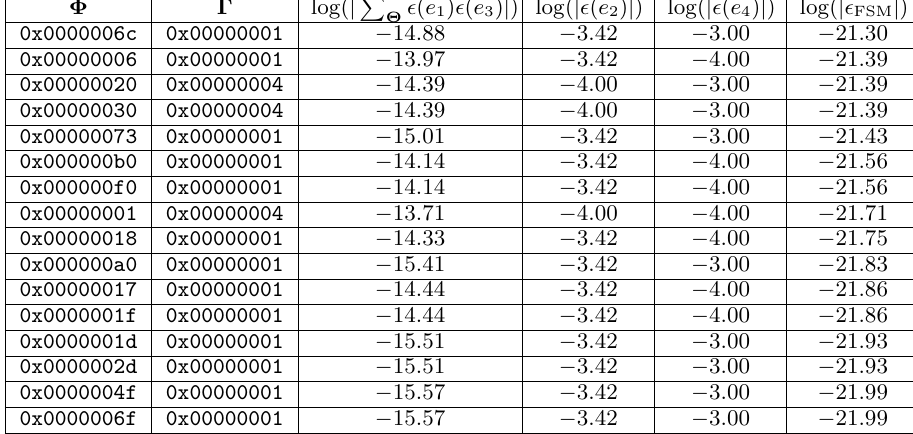
Table 4: The bitwise masks ( Φ , Γ ) for bitwise linear approximation (3) such that 2 − 22 ≤